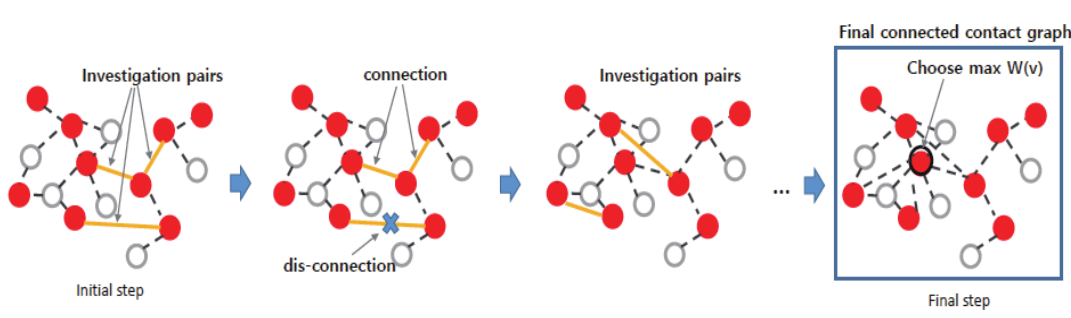
Figure 2. Illustration of the algorithm Dynamic Network Source Estimation (DNSE)( k ). (In the initial step, the network consists of three disconnected subnetworks. Choose k t = 3 to investigate of